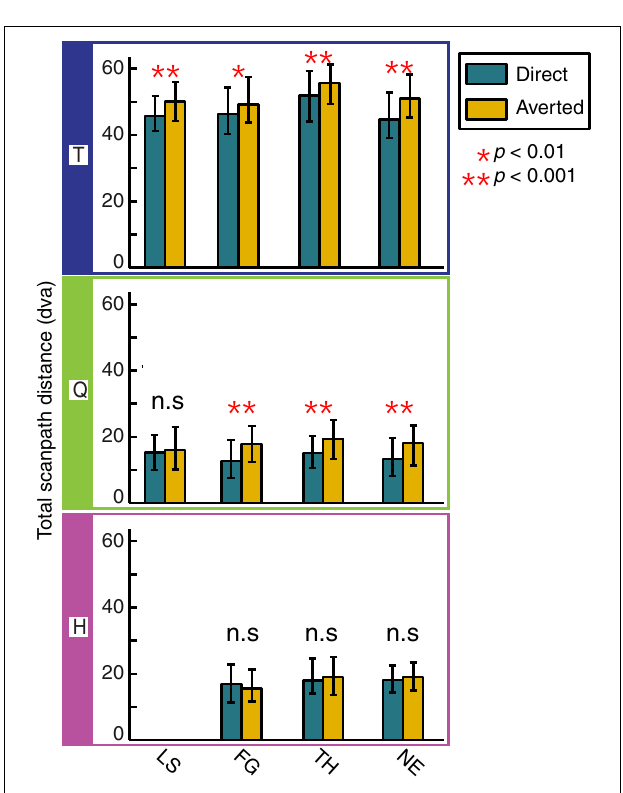
FIGURE 6 | The effect of gaze direction on scanpath length. Scanpath length over averted images is increased for all facial expressions in monkey T, three expressions in monkey Q, and none in monkey H. Bars and whiskers represent median scanpath length in dva and interquartile range,